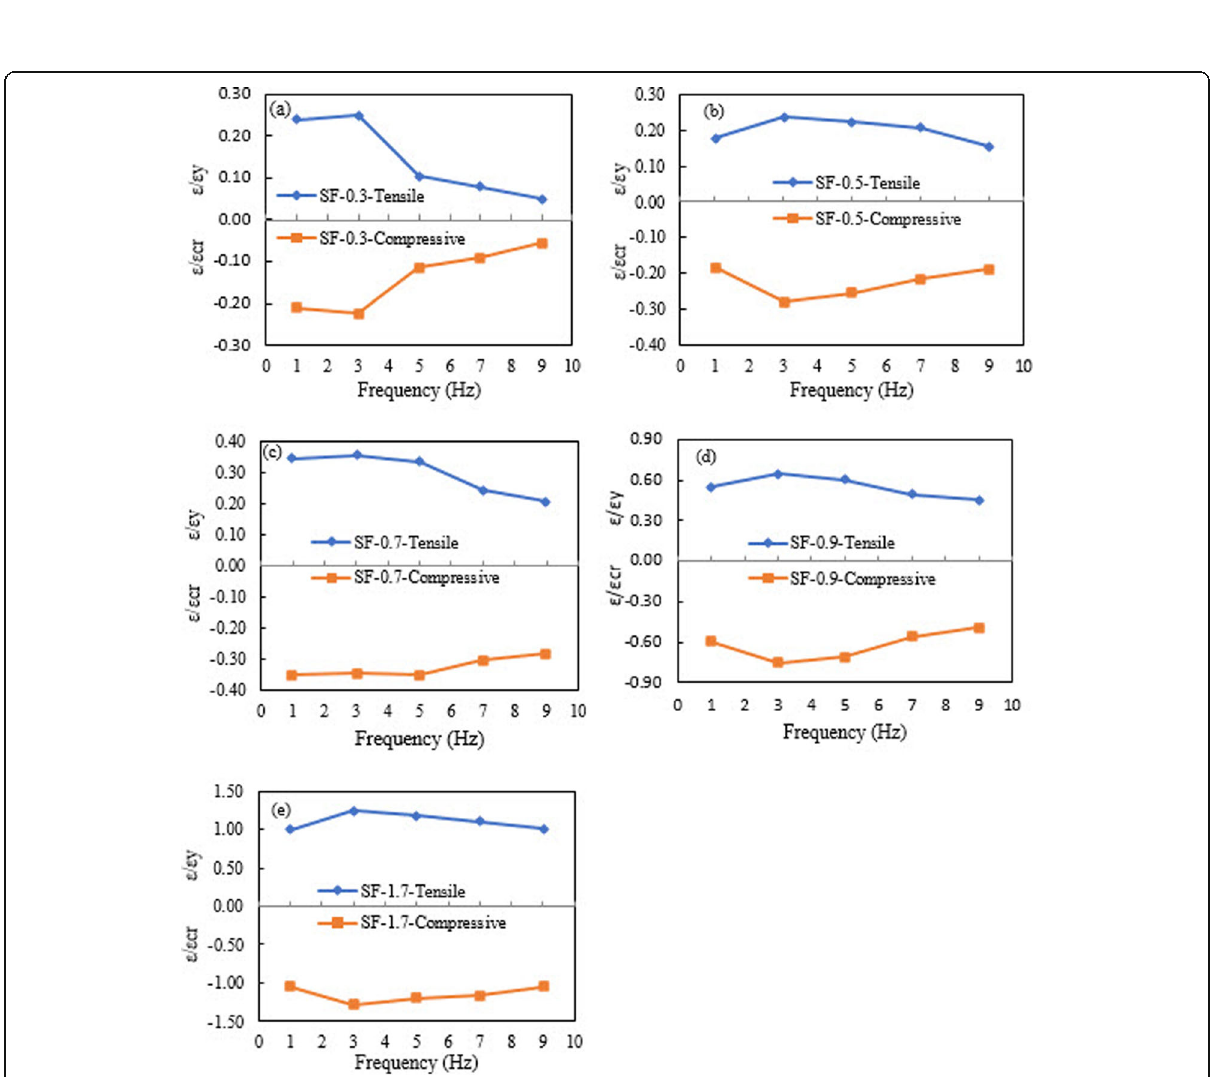
Fig. 14 Effect of frequency of input motion on pipeline strain for rock type R4: ( a ) SR = 0.3; ( b ) SR = 0.5; ( c ) SR = 0.7; (d) SR = 0.9; ( e ) SR =